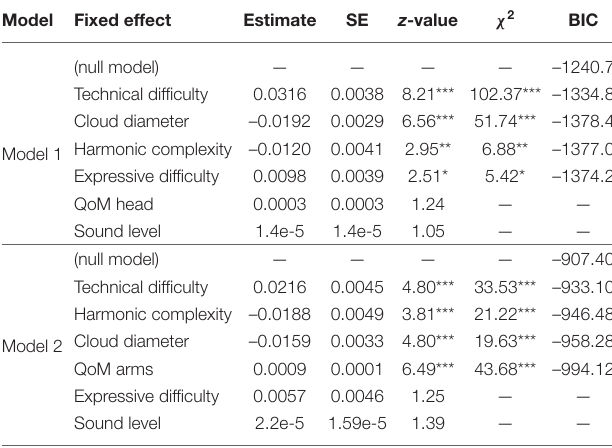
TABLE 1 | Results of linear mixed effects modelling for performers.